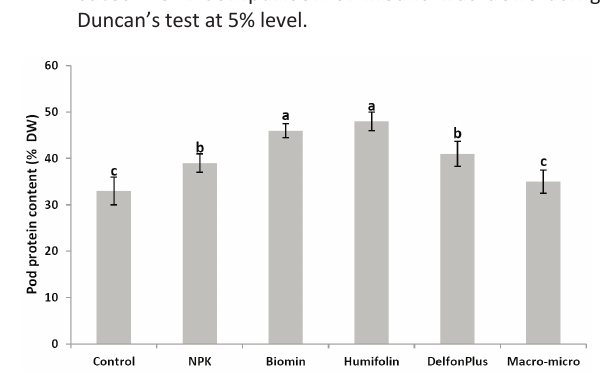
Fig. 3 - Effects of various fertilization treatments on protein con- tent of French bean pods. Data are mean of four replica- tes ± SD. Comparison of means was done using Duncan’s test at 5%